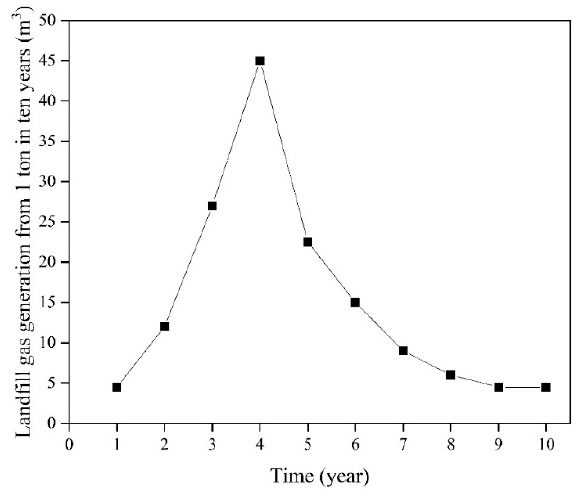
Figure 1. Actual gas production of landfill gas in ten